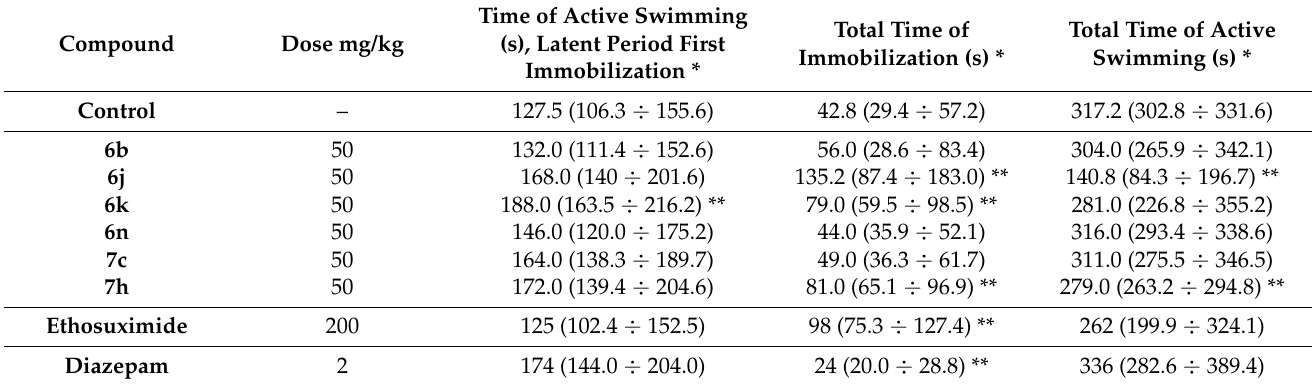
Table 6. Effect of compounds 6b , j , k , n and 7c , h and reference preparations on “forced swimming” (study for 6 min).